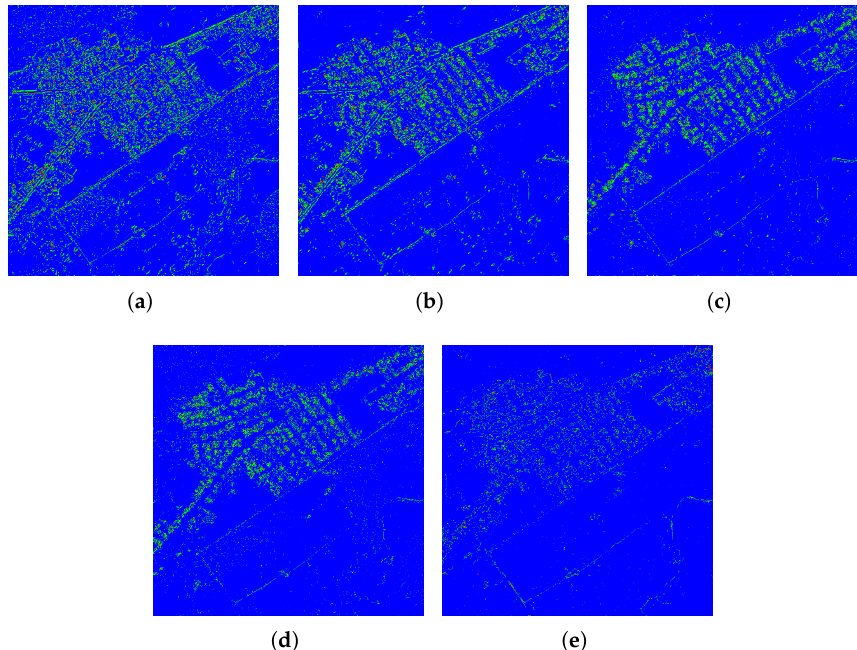
Figure 10. The difference image between the result image and the reference image of the QuickBird data. ( a ) AIHS, ( b ) ATWT, ( c ) PNN, ( d ) MSDCNN, ( e ) the proposed